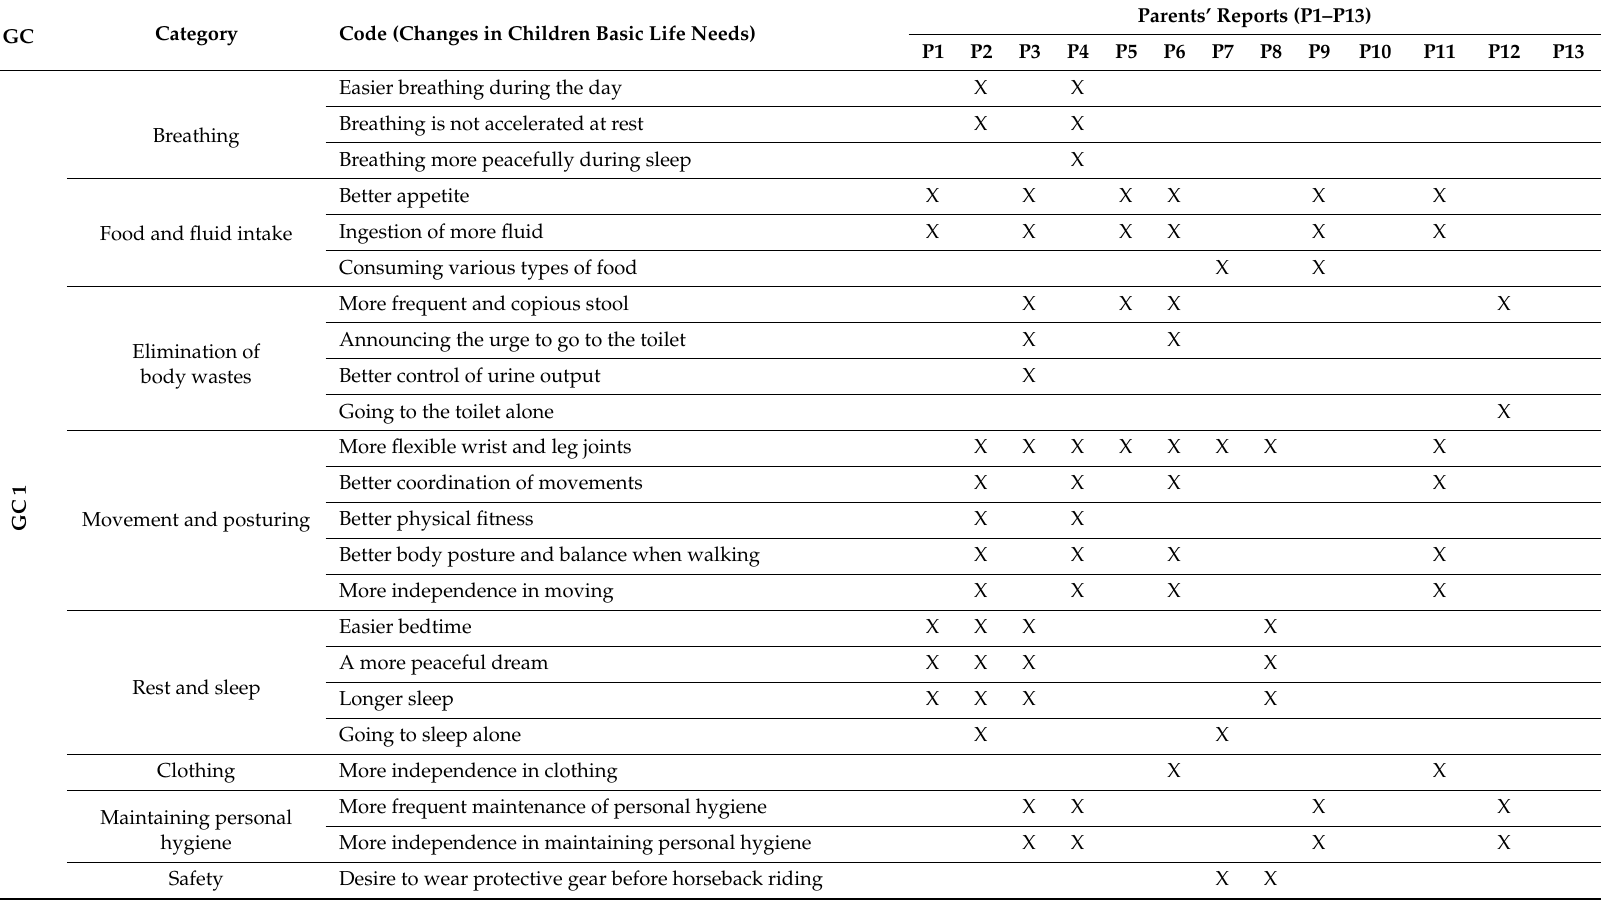
Table 3. The process of data abstraction contained in parents’